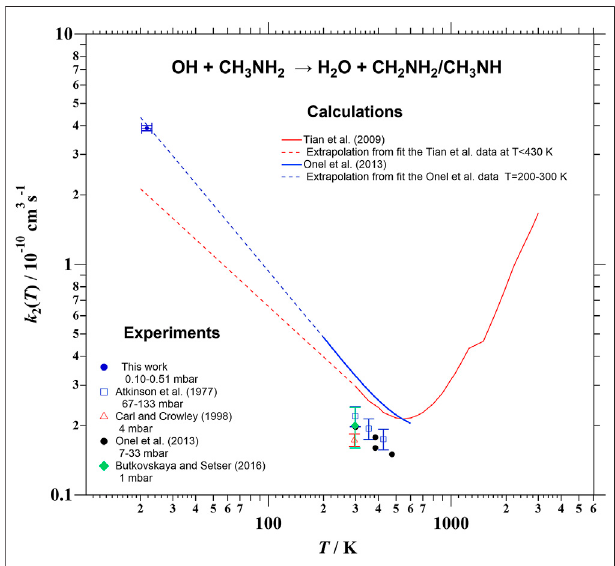
FIGURE 5 | Temperature dependence of k 2 in the 22 – 3,000 K